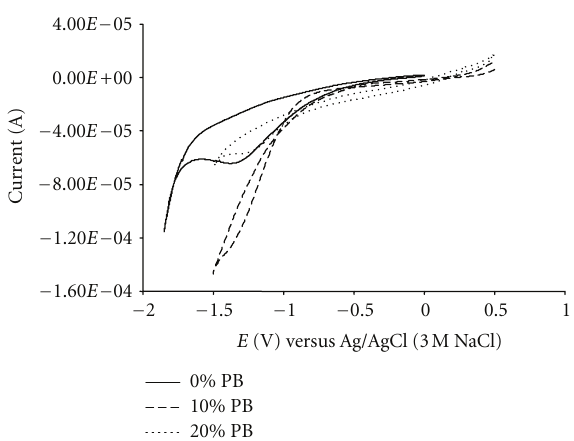
Figure 4: Reduction process of H 2 O 2 on SCNR paste electrodes containing 0% (w/w) PB (solid line), 10% (w/w) PB (dashed line), and 20% (w/w) PB (dotted line). 10.0 mM H 2 O 2 in 0.1 M phosphate bu ff er, pH = 7.0. Scan rate 25mV/s for SCNR paste electrode containing no PB and v = 50mV/s for SCNR paste containing 10 and 20% (w/w)